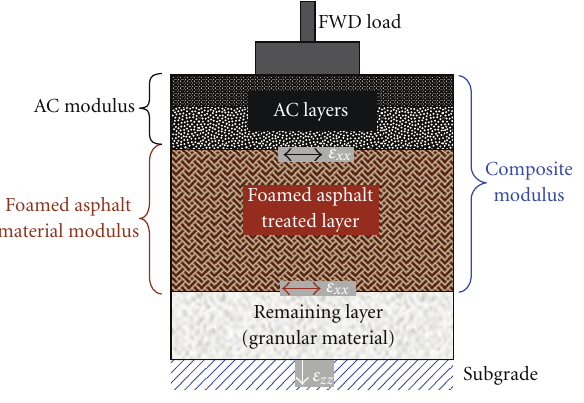
Figure 12: Pavement model for back-analysis.